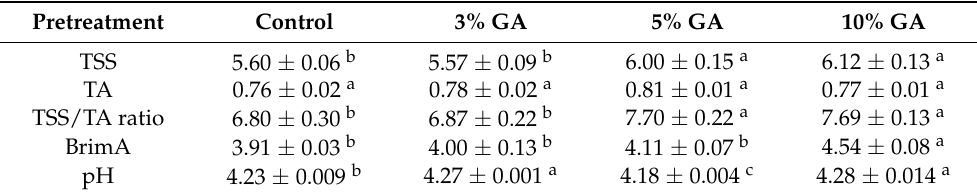
Table 2. Total soluble solids (TSS, ◦ Brix), titratable acidity (TA, mg/100 mL citric acid), TSS/TA ratio, BrimA, and pH of the control, GA-pretreated, and oven-dried (60 ◦ C for 18–24 h)